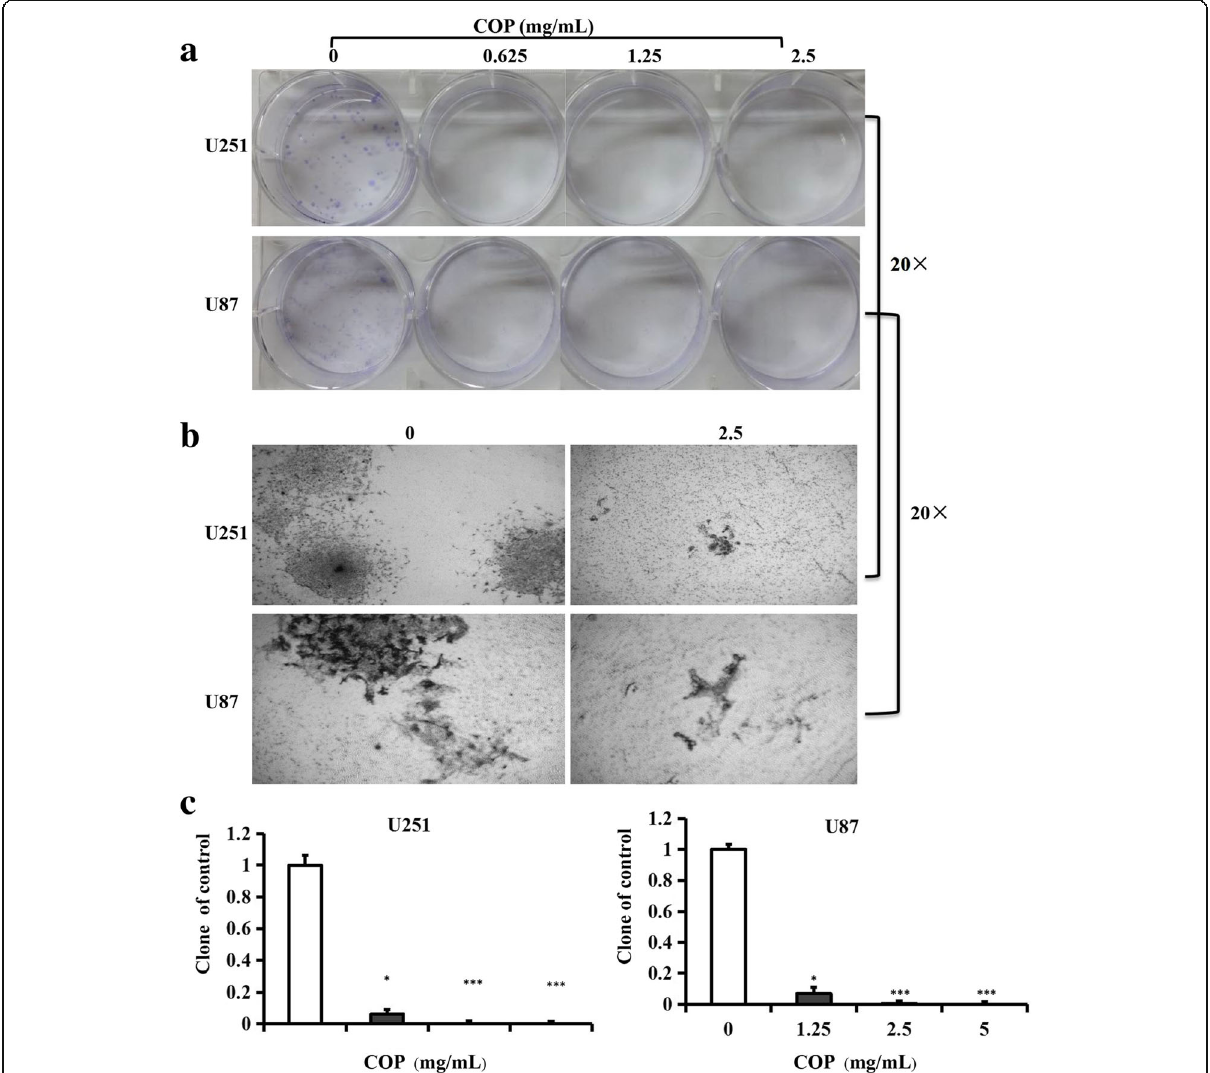
Fig. 3 Effect of COP on colony formation of Glioma cells. U251 and U87 ( a ) cells were treated with COP (0, 0.625, 1.25 and 2.5 mg/ ml) for 24 h and allowed to grow for an additional 12 days. b Photographs of cell culture (0 and 2.5 mg/ml) are shown. c Colony percentages represent the mean ± SD from 3 individual experiments. The number of colonies after treatment with vehicle control was normalized to 100%. *, P < 0.05; **, P < 0.01; ***, P < 0.001 compared with the control